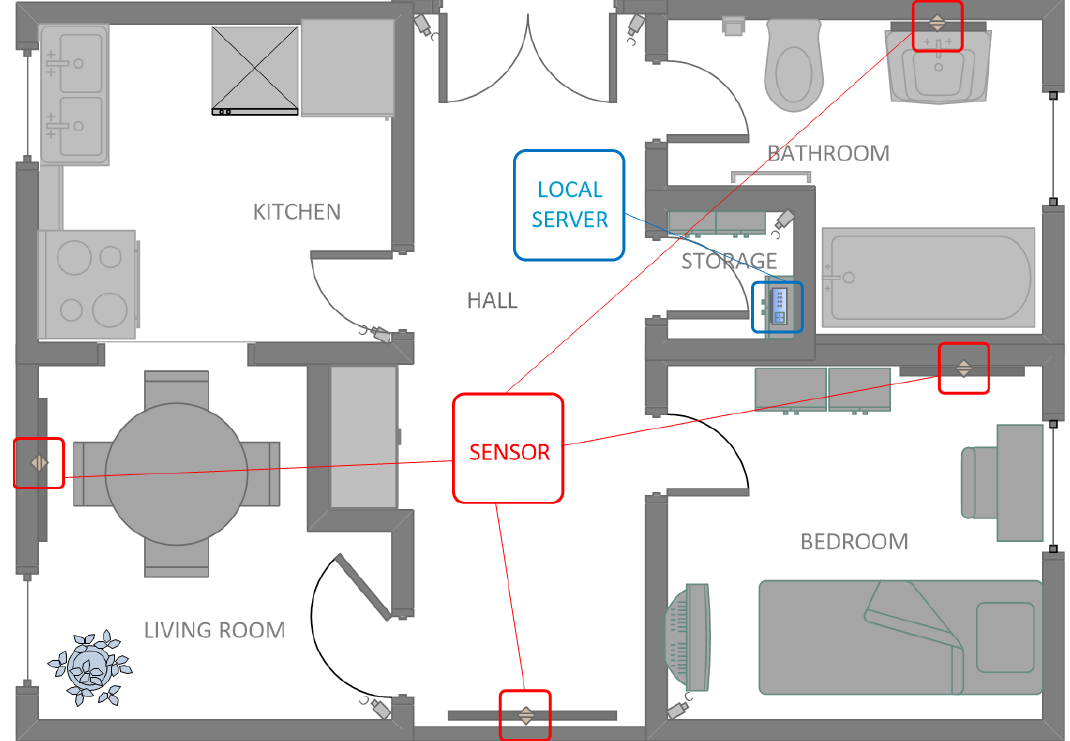
Figure 1. An example of a smart home visualization with the placement of sensors over mirrors in the house (the camera is activated by the motion sensor) and the location of a local data